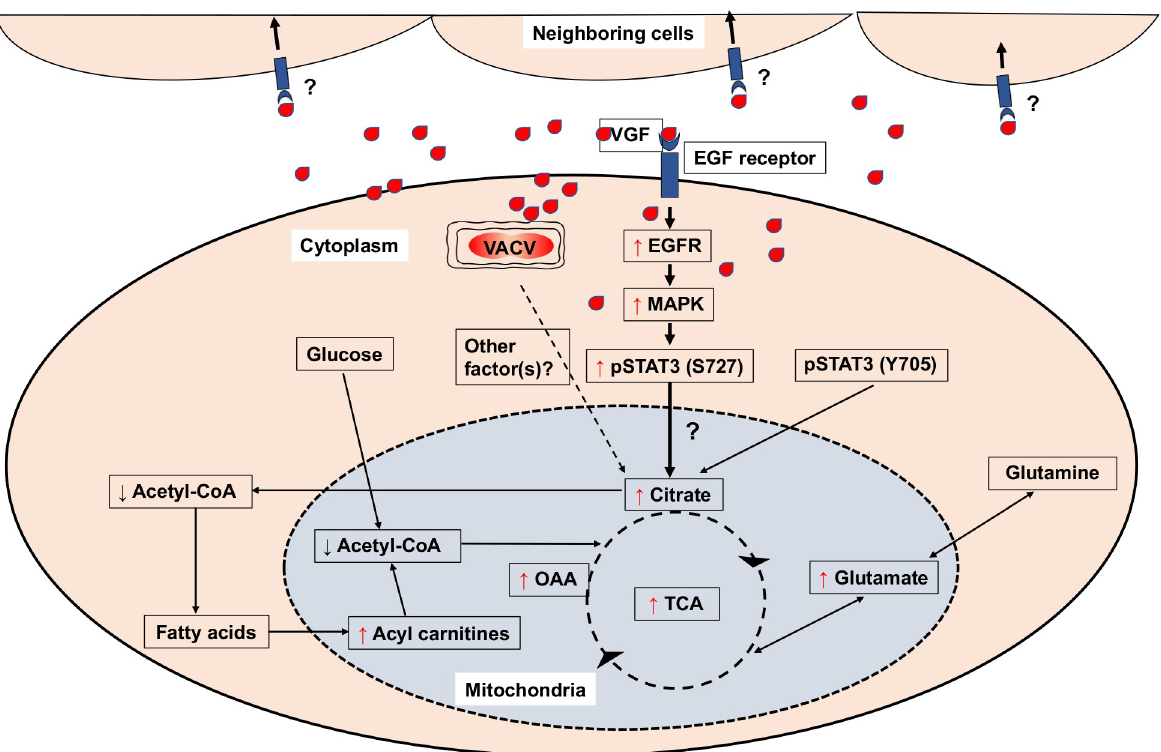
Fig 8. Proposed model by which VACV infection promotes the TCA cycle. VACV infection enhances the levels of TCA cycle intermediates and related products. Upon VACV infection, the levels of Acetyl-CoA decrease, while the levels of fatty acyl carnitines (key metabolites for β -oxidation of fatty acids) increase. The increase in the level of citrate can be attributed to the VACV VGF mediated upregulation of non-canonical STAT3 phosphorylation at S727 via EGFR and MAPK pathways. Although not upregulated by VACV, the Y705 phosphorylation of STAT3 is also important for enhancing citrate level. It is unclear if additional viral factors are also required to elevate the TCA cycle and if VGF alone can exert the function in uninfected cells. Red upward arrows indicate increase and black downward arrows indicate decrease of indicated